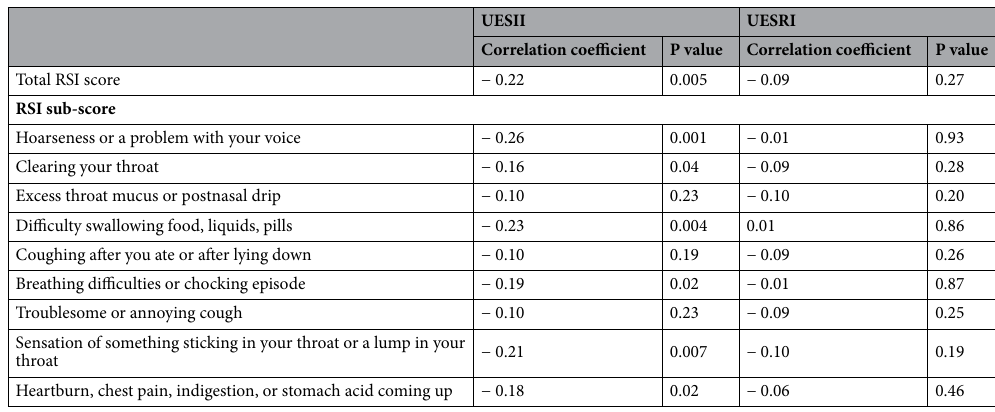
Table 2. Correlation between upper esophageal sphincter impedance integral (UESII), and upper esophageal sphincter relaxation integral (UESRI) with reflux symptom index